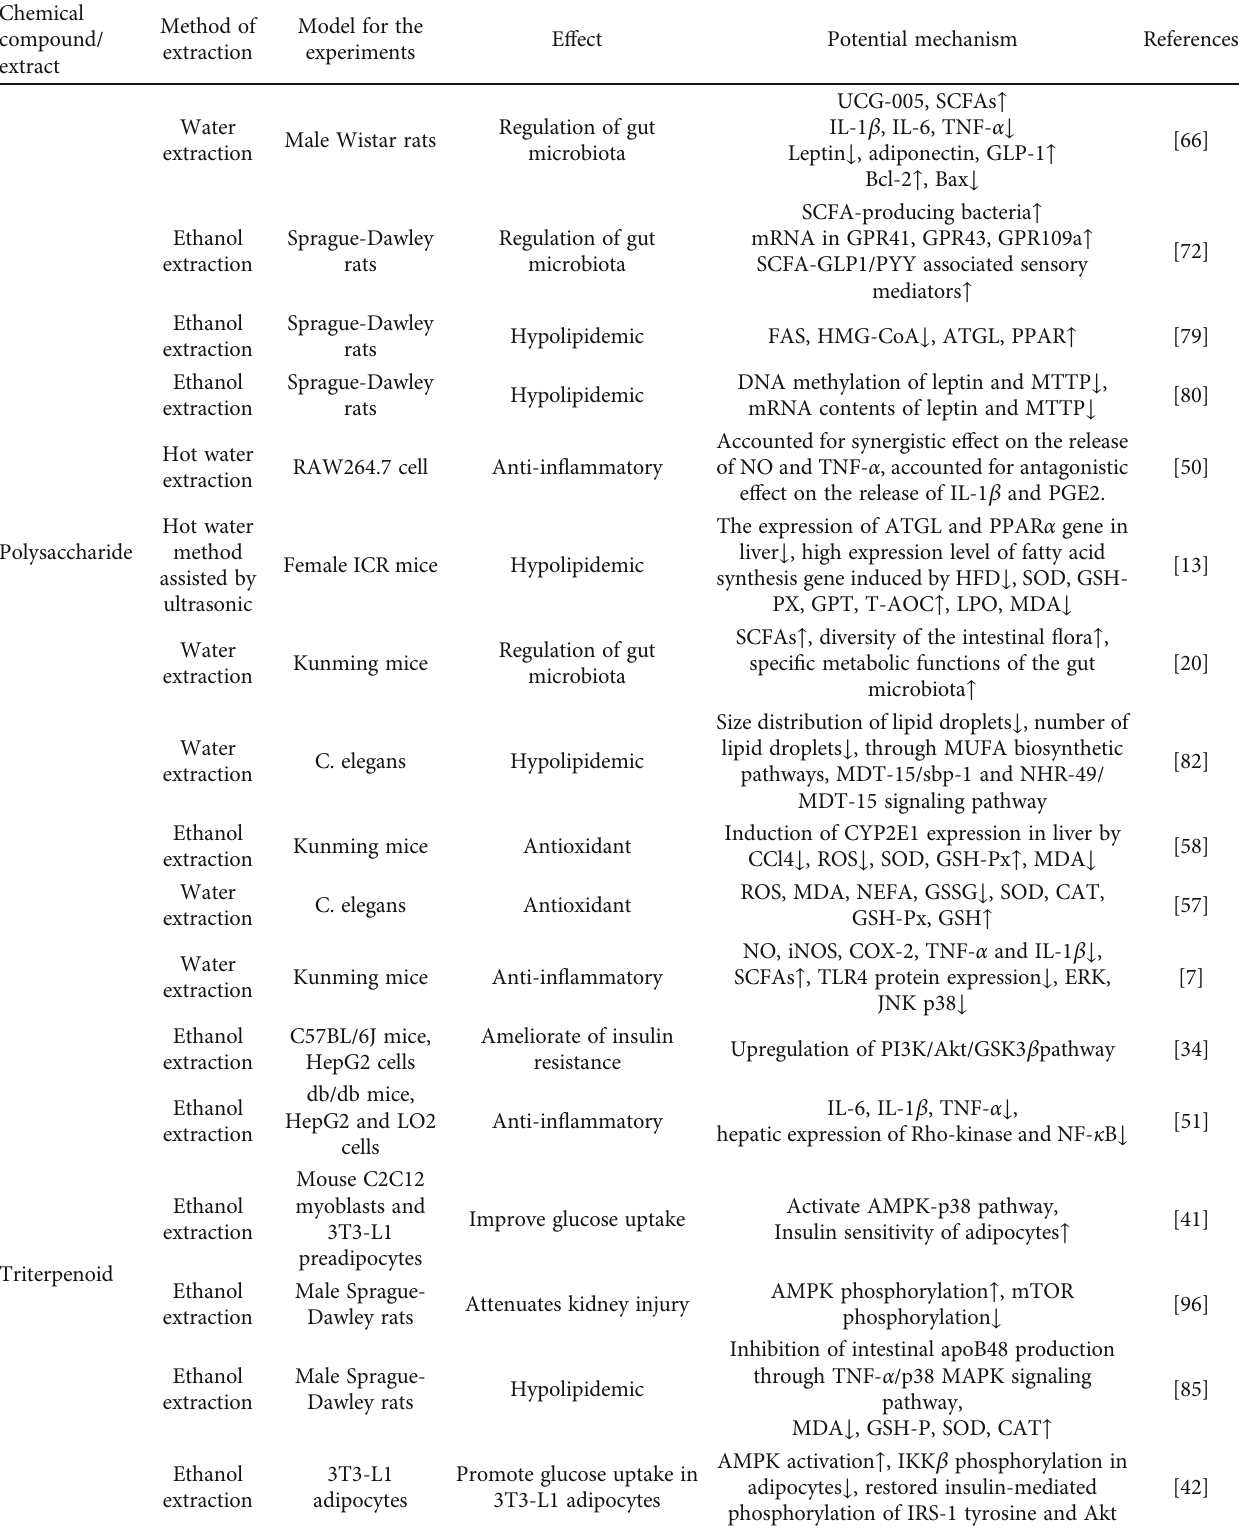
Table 1: Potential role of the major compounds and extracts of C. paliurus in T2DM and its